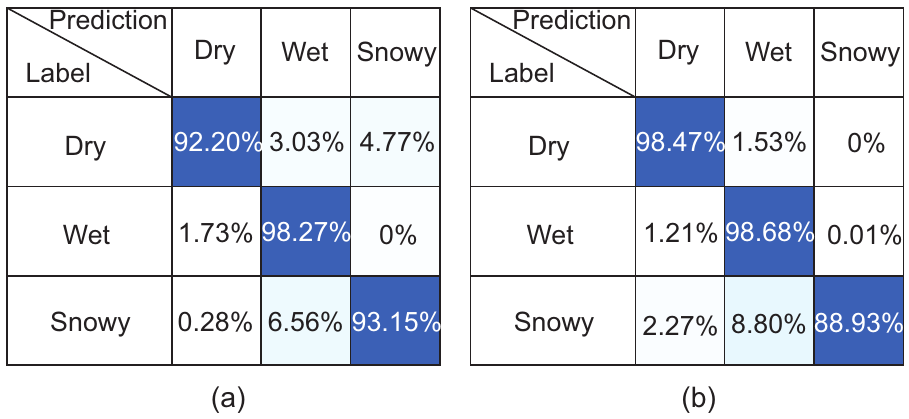
Figure 5. ( a ) Confusion matrix of DenseNet121 model for database with ambient illumination. ( b ) Confusion matrix of DenseNet121 model for database without ambient